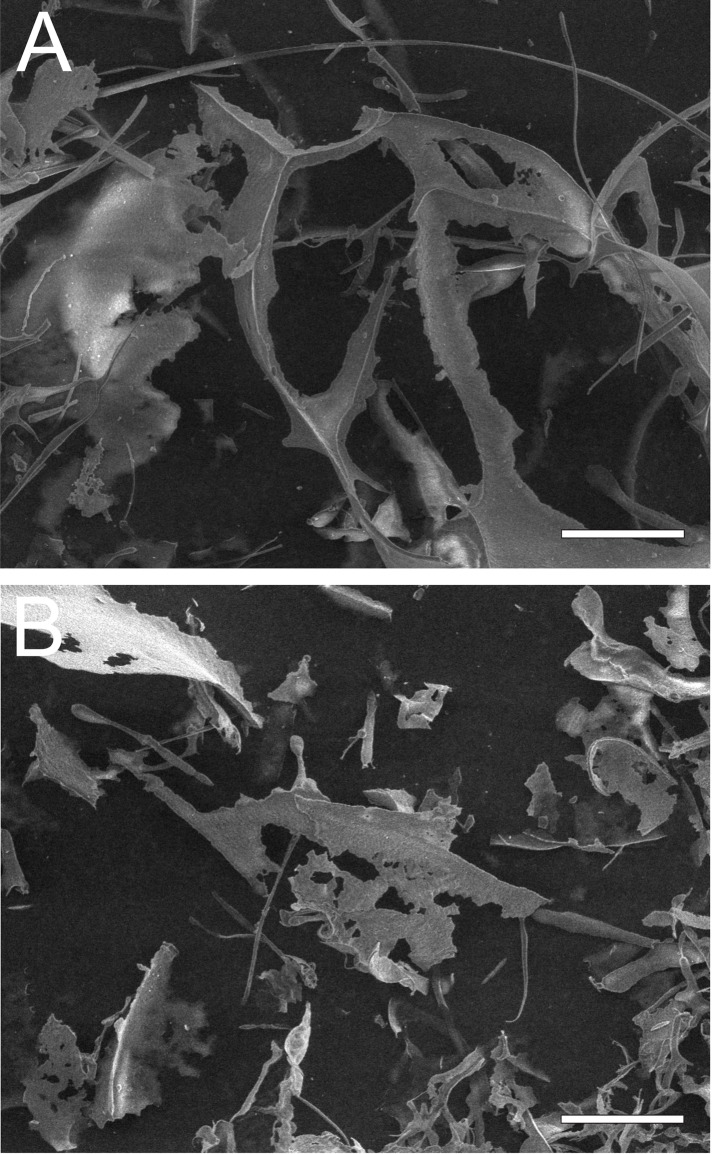
SEM image of the AAF.Fraction lyophilizate documented using QuantaTM 3D FEG. Bars represent 50 μm.